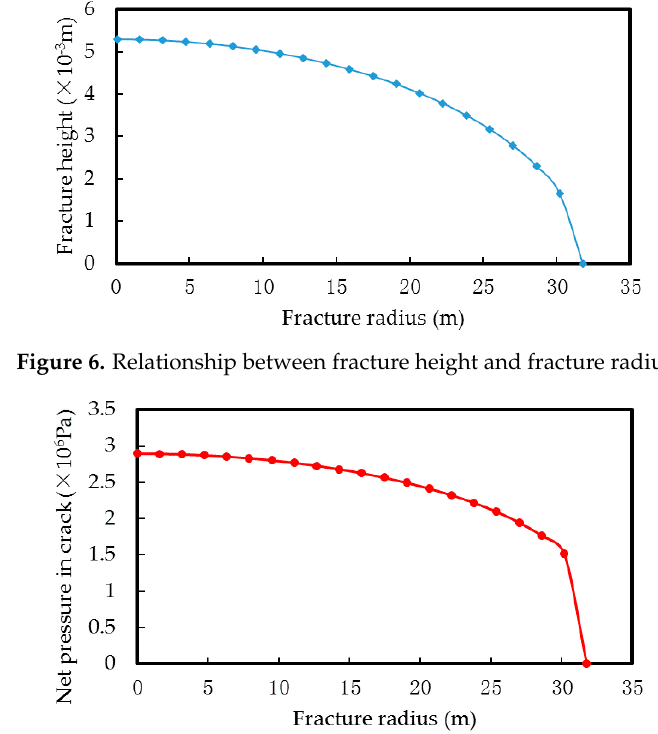
Figure 7. Relationship between pressure and radius in fracture.